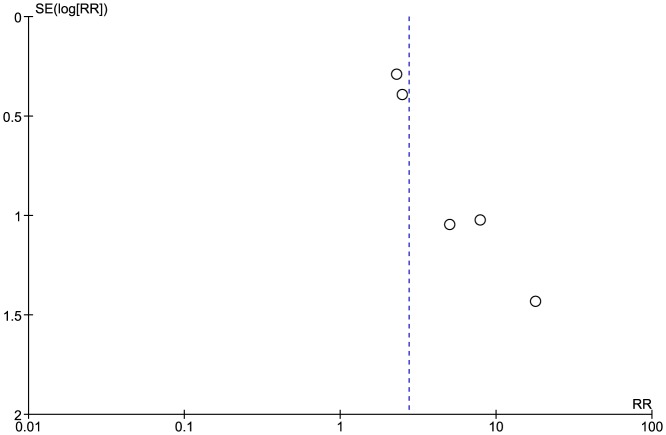
Funnel plot: Low grade stenosis.